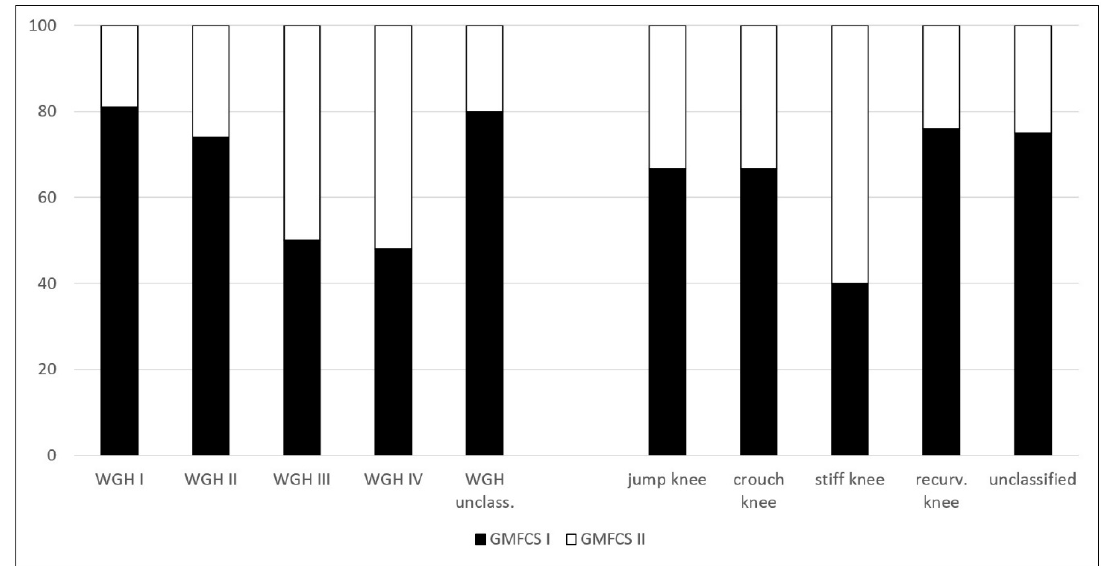
Figure 2. Percentage distribution of Gross Motor Function Classification System (GMFCS) levels within the different morphologic subgroups.